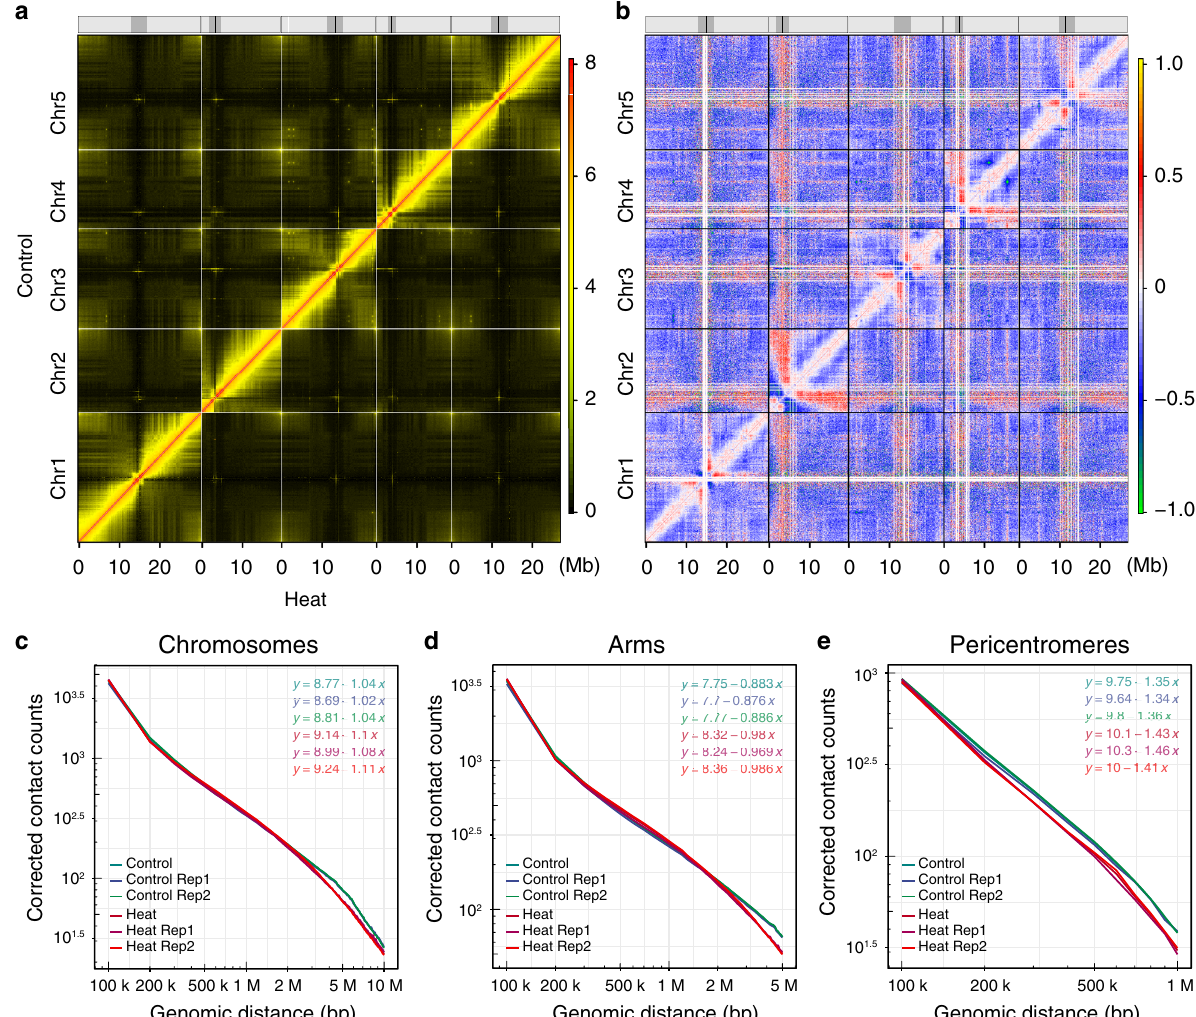
Fig. 3 Heat induces rearrangement of chromatin organization. a Genome-wide chromatin organization revealed by a Hi-C interaction frequency heatmap at 100 kb resolution for all Arabidopsis chromosomes in Control and Heat. Each pixel denotes all interactions between any two 100 kb genomic loci from the linear genome. Intensity represents log 2 normalized contact frequencies. The top track shows the positions of centromeres (black) and pericentromeres (gray). b Genome-wide heatmap of relative interaction differences between Heat and Control. The relative difference is calculated as the difference of two interaction frequencies divided by the mean of two interaction frequencies. In the plot, Hi-C interactions that become stronger (chromosome condensation) in Heat compared with Control are in red to orange, while Hi-C interactions that become weaker (chromosome loosening) in Heat compared with Control are in blue to green. Hi-C interactions that do not change in Heat compared with Control are in white. The genomic bin size is 100 kb and the upper- and lower-triangular matrices are symmetric. The top track shows the positions of centromeres (black) and pericentromeres (gray). c Averaged scaling plot of interaction frequencies against increasing genomic distance for all Arabidopsis chromosomes. The genomic bin size is 100 kb. d Averaged scaling plot of interaction frequencies against increasing genomic distance for all Arabidopsis chromosome arms. The genomic bin size is 100 kb. e Averaged scaling plot of interaction frequencies against increasing genomic distance for all Arabidopsis pericentromeric regions. The genomic bin size is 100